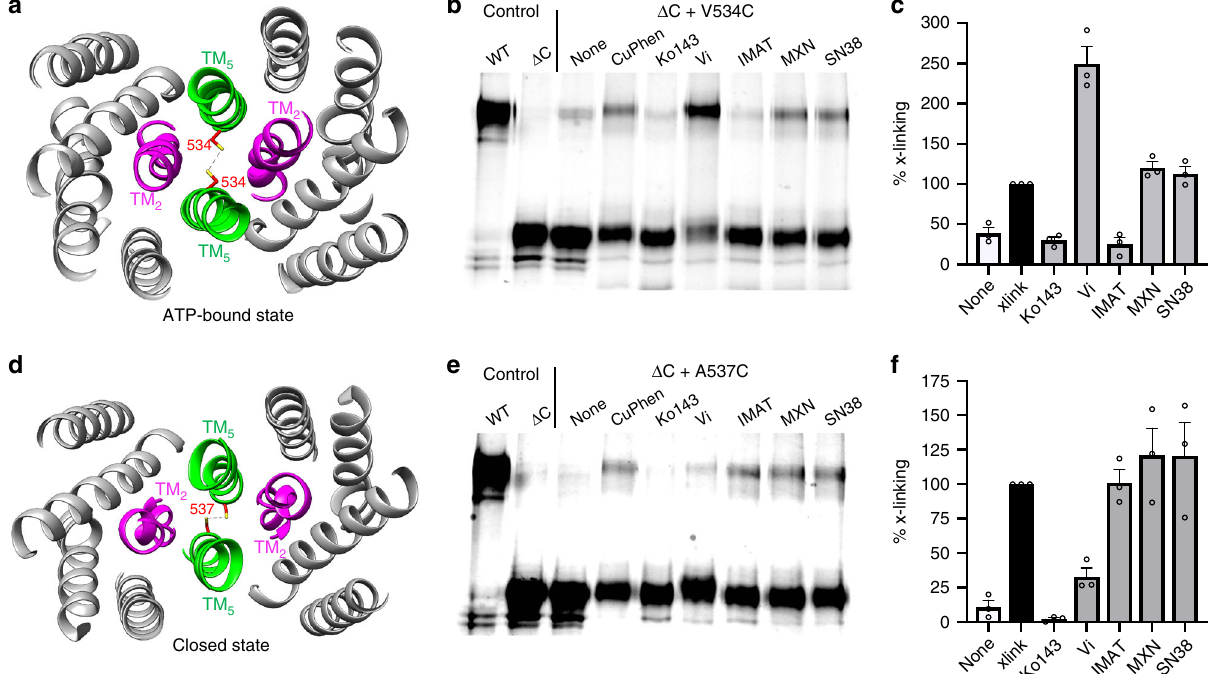
Fig. 2 Disul fi de crosslinking of ABCG2 in different conformational states. a View from the extracellular space of ABCG2 TM helices in the ATP bound state (PDBid 6HZM). A cysteine was introduced at position 534 to probe disul fi de crosslinking across the dimer interface. b Non-reducing SDS-PAGE with in-gel GFP fl uorescence to monitor oxidant-induced crosslinking of the Val534Cys mutant. Upper band represents disul fi de crosslinked ABCG2. c Densitometry quanti fi cation of crosslinking in ( b ). Data represents the average of three independent experiments with SEM. d View from the extracellular space of ABCG2 TM helices in the apo-closed state. A cysteine was introduced at position 537 to probe disul fi de crosslinking across the dimer interface. e Non-reducing SDS-PAGE with in-gel GFP fl uorescence to monitor oxidant-induced crosslinking of the Val534Cys mutant. Upper band represents disul fi de crosslinked ABCG2. f Densitometry quanti fi cation of crosslinking in ( e ). Data represents the average of three independent experiments with SEM. Source data are provided as a Source data fi